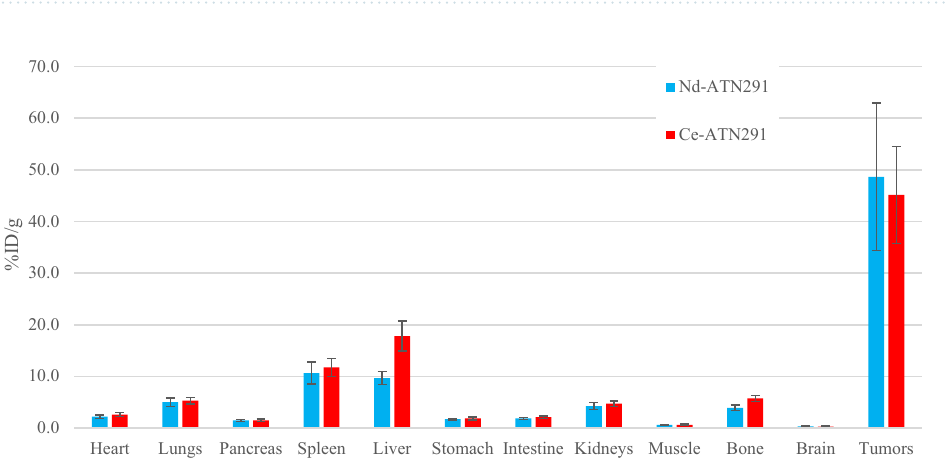
Figure 5. Changes in PET signals due to the parent-daughter separation following EC decay of the parent expressed as percentage differences between daughter (AM) and parent (PM) relative to the parent PET quantification. A negative value indicates that the daughter radioisotope ( 140 Pr, or 134 La) was actively being removed from the ROI while the animal was alive. Error bars represent the standard deviation of the ratio between the daughter and parent signals expressed in percentage. These comparisons are made for the labeled- mAb injections only.